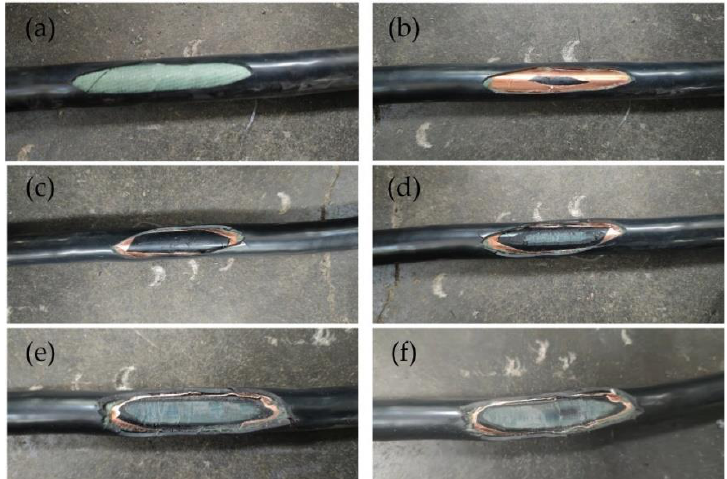
Figure 7. The abrasion condition of the cable sample: ( a ) The sheath was partly removed; ( b ) The slight abrasion of the copper shields; ( c ) The serious abrasion of the copper shields; ( d ) The abrasion of the semiconducting layer. ( e ) The slight abrasion of the insulation. ( f ) The serious abrasion of the